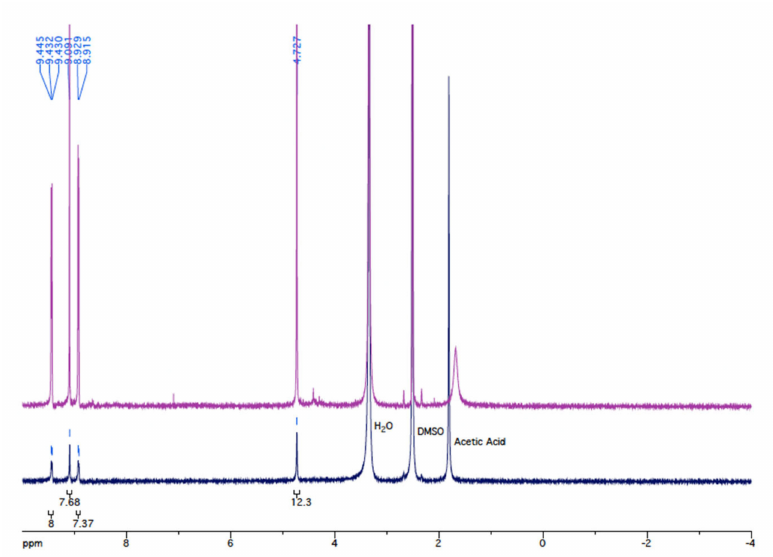
Figure 3. 1 H-NMR (DMSO-d 6 ) of the reaction (TMePyP and 1 equivalent of Zn(OAc) 2 , 1 mL of water, 30 min under ultrasound) after solvent evaporation (blue line) and after purification through exclusion column chromatography (magenta